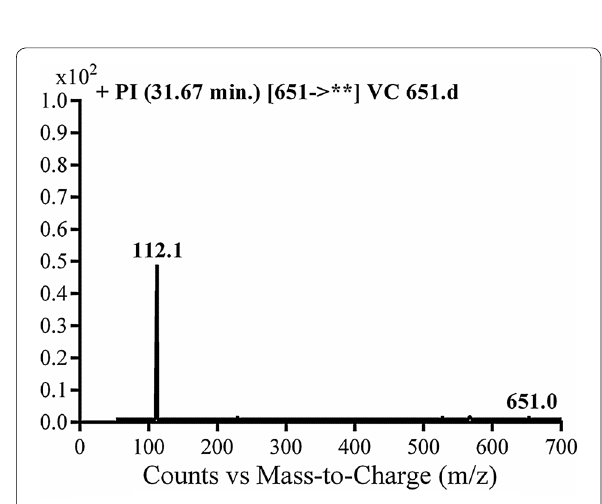
Fig. 9 PI mass spectrum of